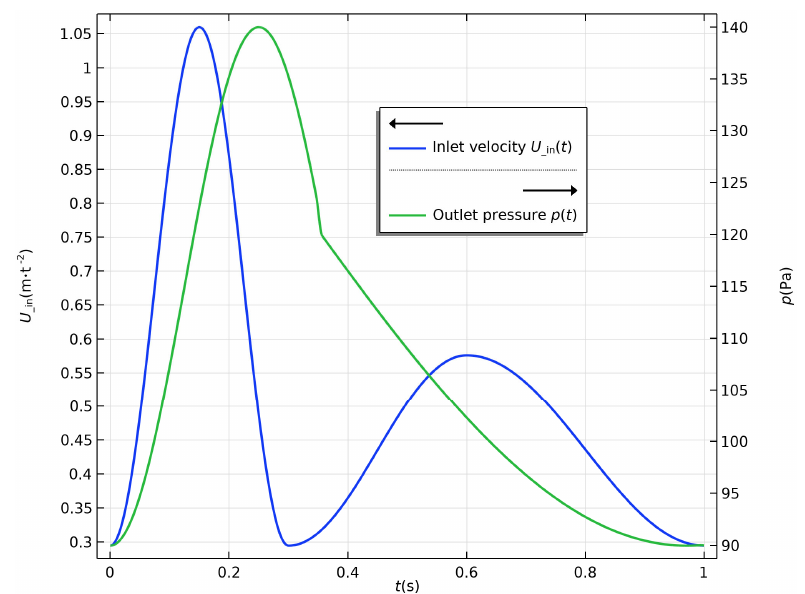
Figure 3. Inlet and outlet boundary